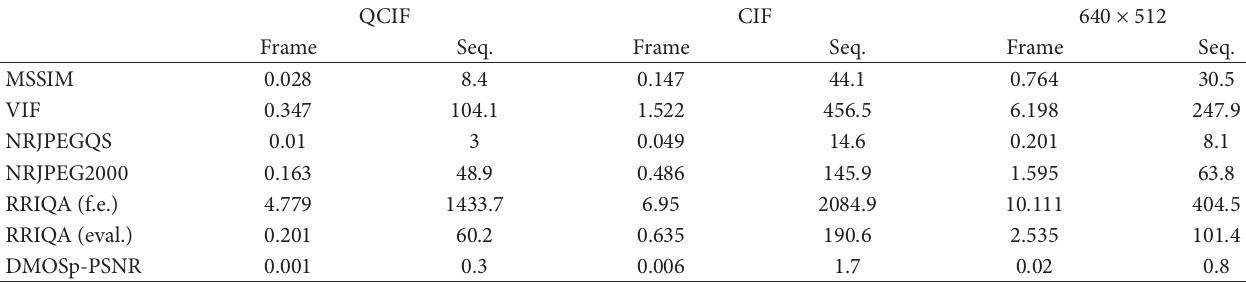
Table 4: QAM average scoring times (seconds) at frame and sequence